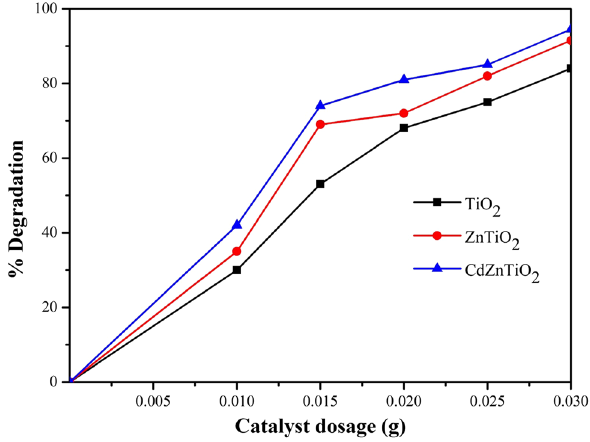
Fig. 9 Comparison of %degradation of MB dye photodegraded by different dosages of TiO 2 , ZnTiO 2 and CdZnTiO